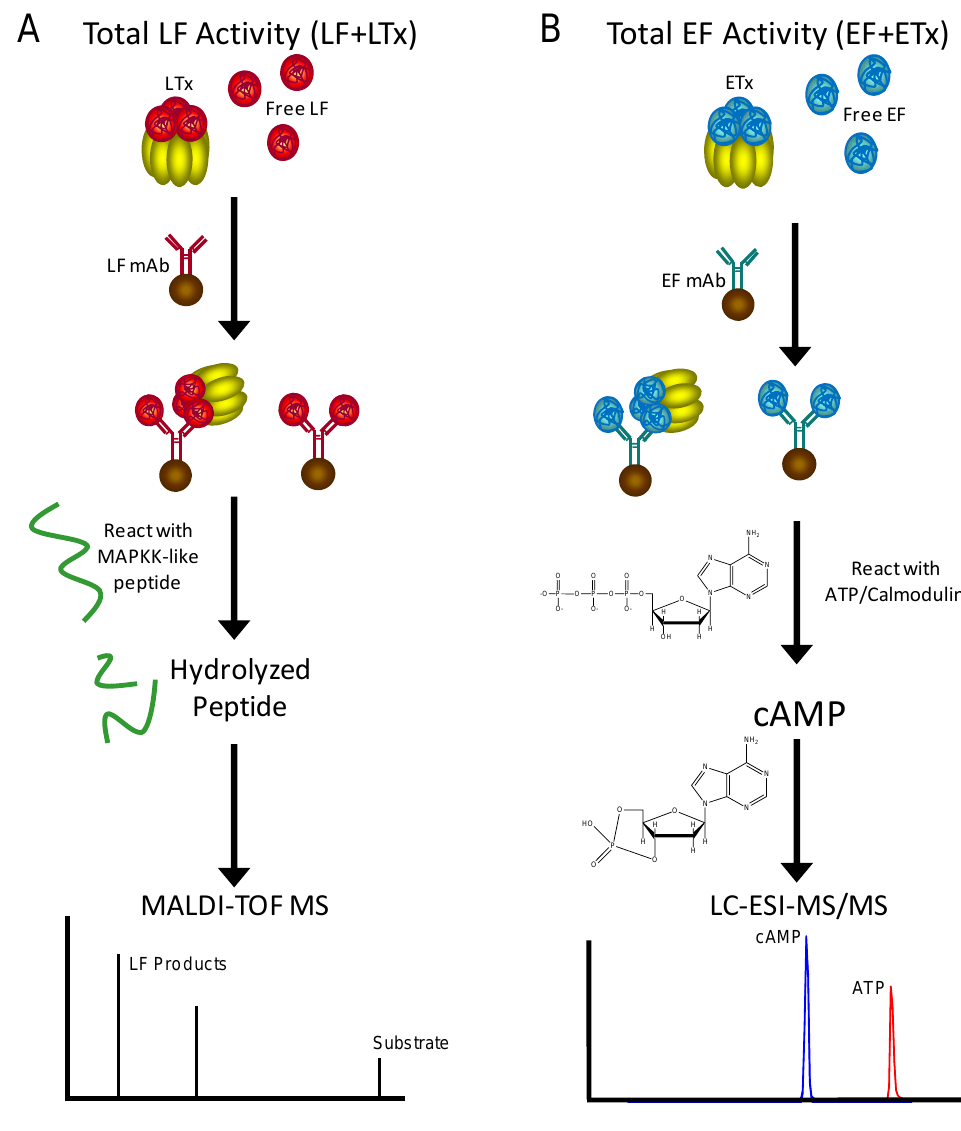
Figure 2. Schematic for total LF (LF+LTx) (A) and total EF (EF+ETx) detection by mass spectrometry. LF is captured by monoclonal antibodies (mAbs), mixed with a synthetic peptide substrate that is hydrolyzed, then the remaining substrate and two hydrolysis products are detected by MALDI-TOF MS. EF is captured by mAbs, then incubated with ATP and the adenylyl cyclase cofactor calmodulin, then ATP and the adenylyl cyclase reaction product cAMP are detected by